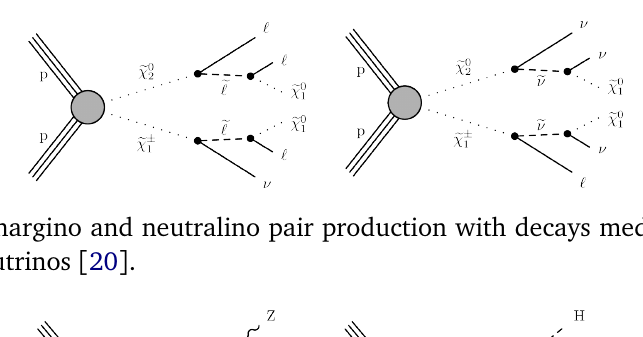
, ˜ χ ± and ˜ χ 0 are 2 1 1